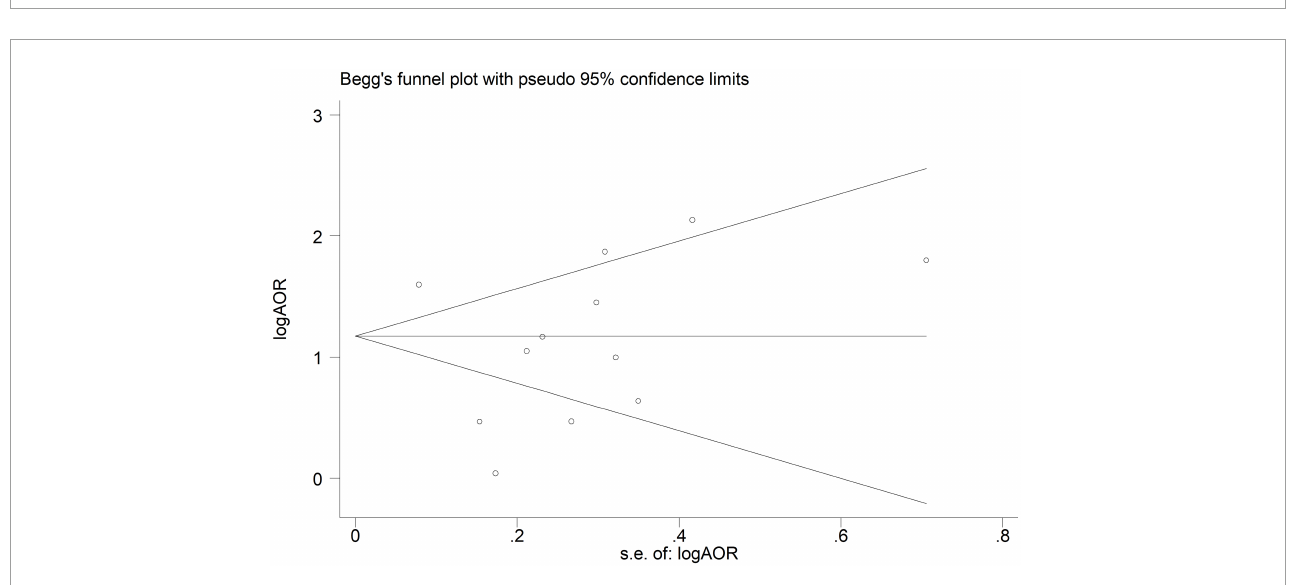
FIGURE6 Begg’s funnel plot of included studies assessing the publication bias in studies addressing the association between binge-drinking and current